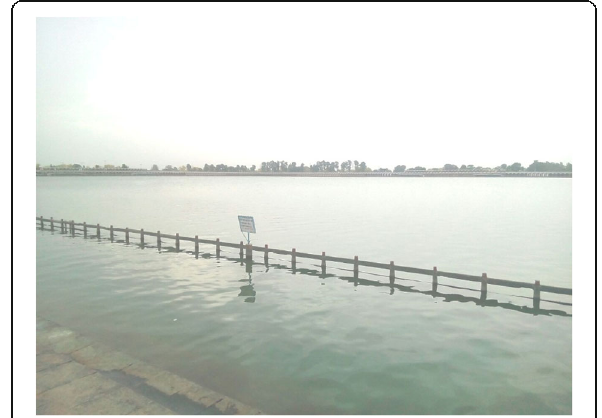
Fig. 1 Photograph of Braham Sarovar